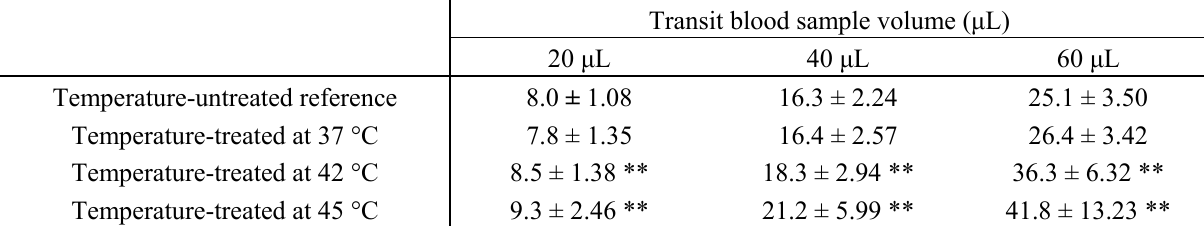
Table 2. Summary of the mean ± standard deviation of transit time of blood samples (s) for a given transit sample volume ( μ L). Prior to application to MC-FAN, blood samples were subjected to mild heating at 37 °C, 42 °C and 45 °C for 30 min, respectively. The number of subjects was 10. Significant differences ( p < 0.001) of the temperature-treated samples against the temperature-untreated reference were shown as